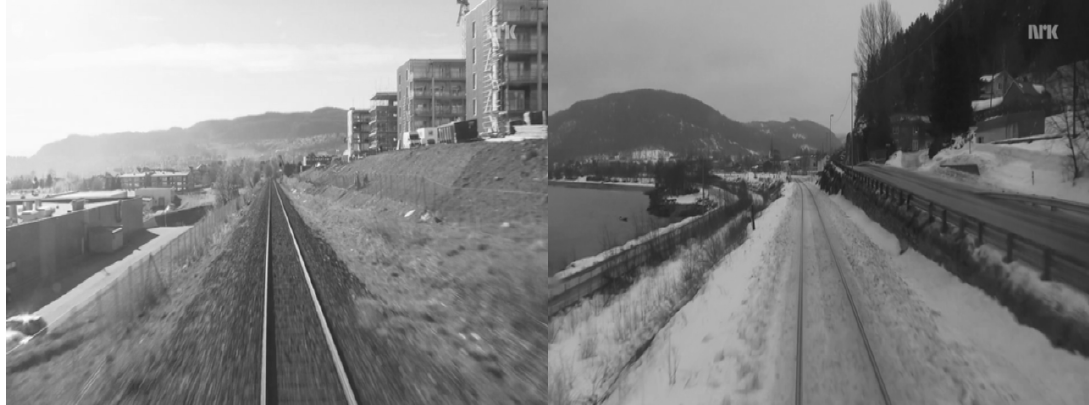
Figure 12. An example when the algorithm fails. The aliasing between the queried image (left side) and the image in memory returned by the algorithm is